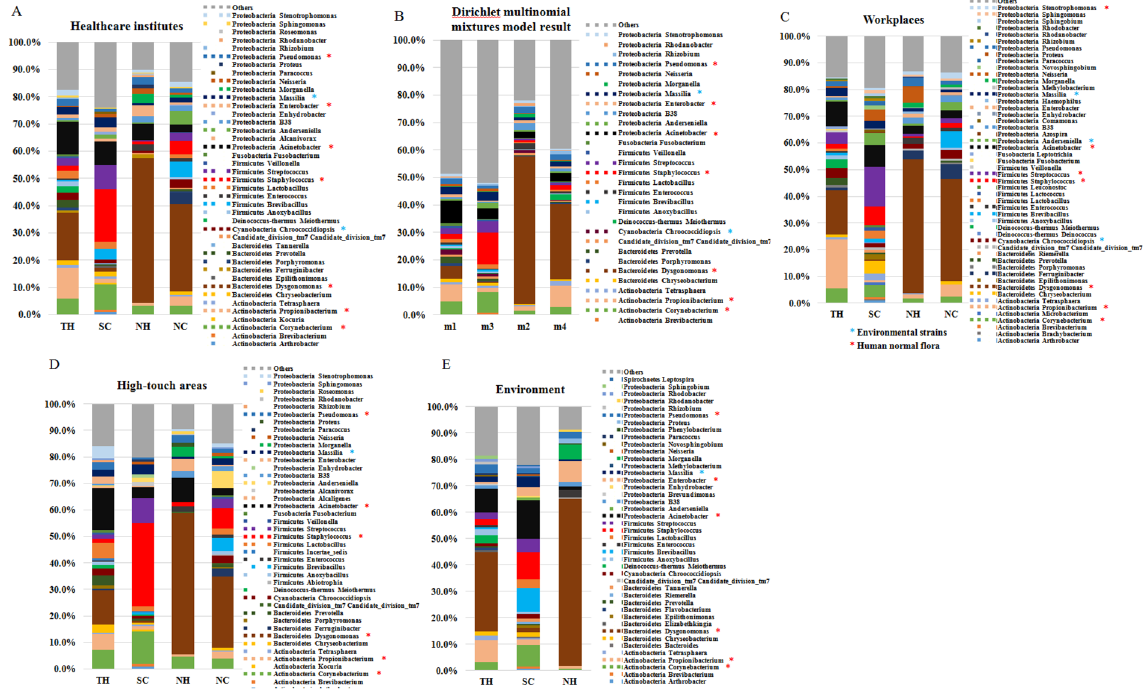
Figure 2. The bacterial communities of four healthcare-associated institutes ( A ). The bacterial communities from the sampling sites in each institute were classified by the DMM-based method ( B ). The bacterial communities from the sampling sites in each institute were classified into workplaces ( C ), high-touch areas ( D ), and environments ( E ). The relative composition of the genera was determined by 16S rRNA amplicon sequencing. Only each healthcare institutes’ genera with > 0.5% abundance on average were included. Multi- colored charts in the legend are shown for each genus and sample.